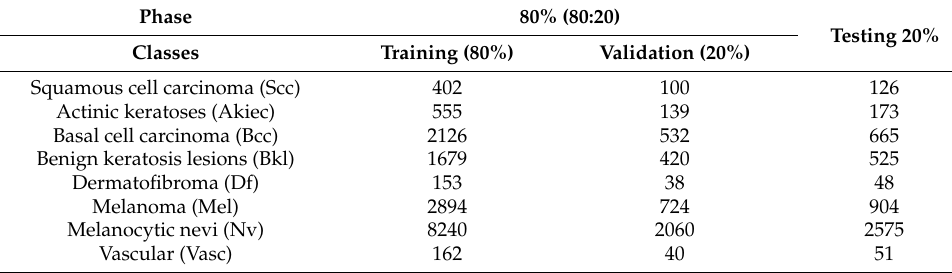
Table 1. Splitting the ISIC 2019 data sets of skin